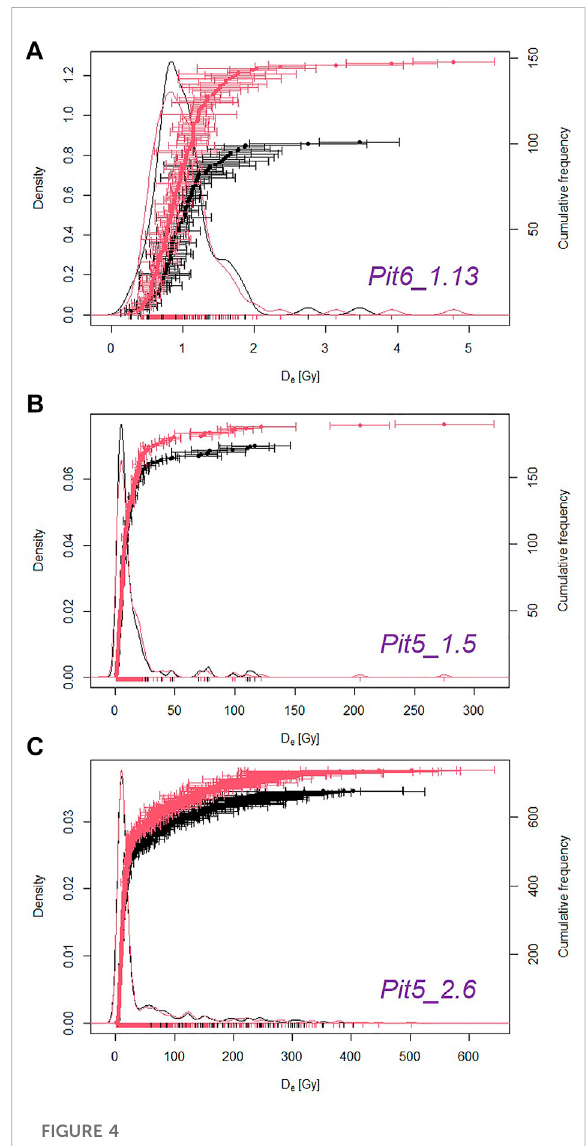
FIGURE 4 Comparison of the D e values derived using rSGCs ( σ b =0, black color) and those derived using cSGCs (red color). (A) Sample Pit 6_1.13; (B) Sample Pit5_1.15; (C) Sample